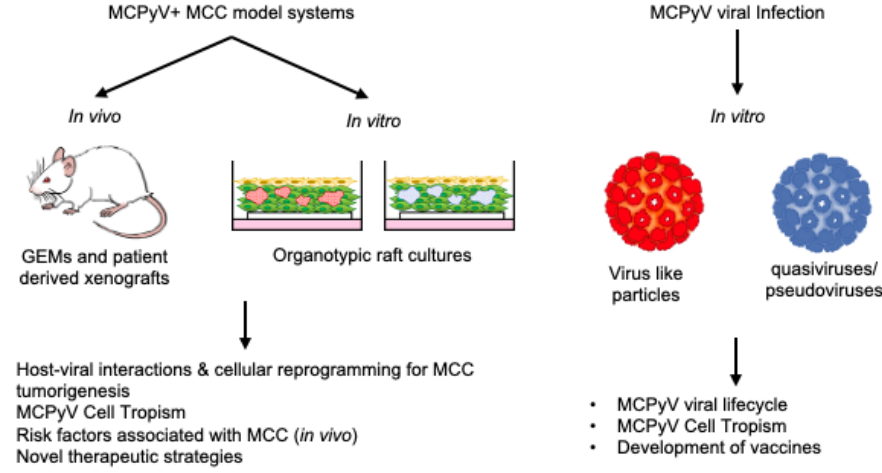
Figure 2. In vitro and in vivo biological model systems for MCPyV infection and MCPyV+ MCC research and their utilities.